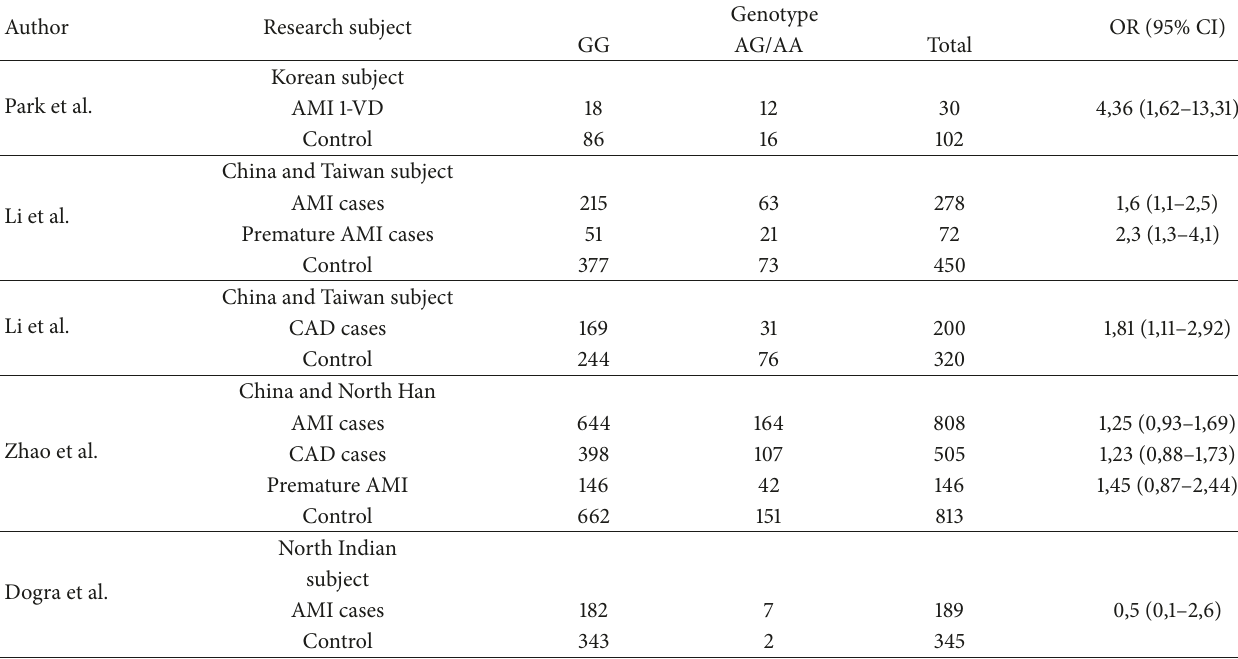
Table 7: Research summary of thrombomodulin gene polymorphisms on other